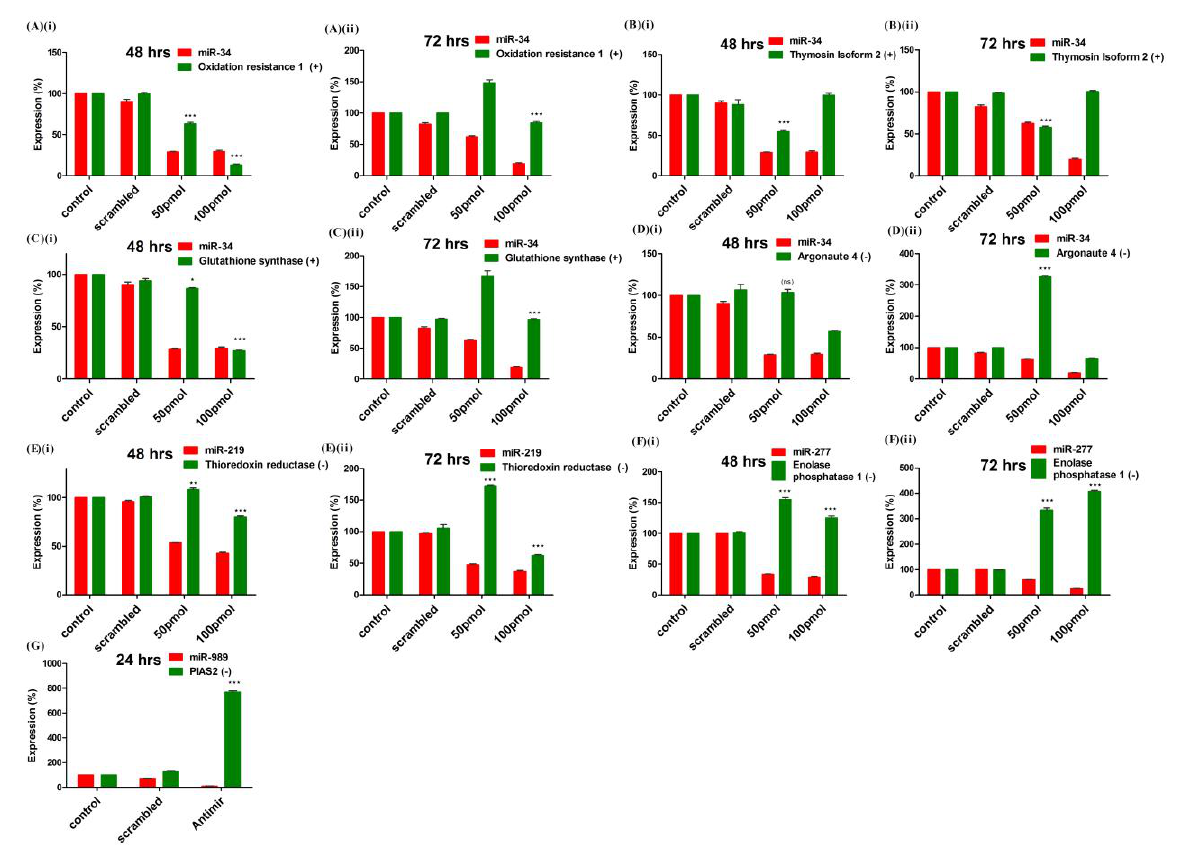
Figure 6. Validation of targets by miRNAs loss of function strategy: Expression profiling of mRNA target(s) of ( A – D ) miR-34; ( E ) miR-219 and ( F ) miR-277 was carried out by RT-PCR in control, scrambled and antagomir transfected cells. Expression (%) of mRNA was compared with miRNA expression at ( i ) 48 h and ( ii ) 72 h post-transfection; ( G ) MiRNA-989 target expression was profiled by RT-PCR in midgut of control, scrambled and miR-989 specific antagomir injected female mosquitoes. Expression (%) of miRNA and mRNA was compared at 24 h post blood-feeding. Expression (%) of mRNAs in control was taken as 100. Values are mean ± s.e.m of three biological replicates profiled in triplicate reaction. Data were statistically analyzed by one-way ANOVA followed by Tukey’s multiple comparisons test. * p < 0.05 was considered significant ( ** p < 0.01, *** p < 0.001). ns = No significant